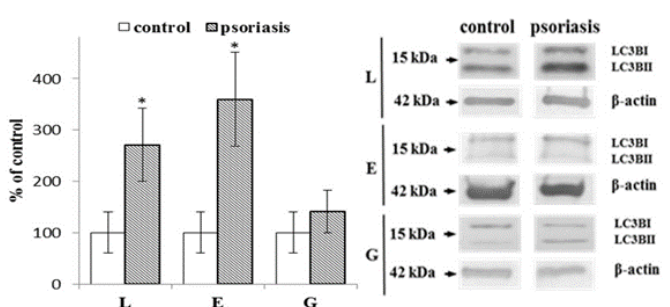
Figure 4. The ratio of LC3BII / LC3BI expression in lymphocytes (L), erythrocytes (E), and granulocytes (G) from psoriatic patients ( n = 6), in comparison to healthy subjects (control), ( n = 6). Values are expressed as a percentage of control. ∗ —statistical significance at p < 0.05 vs. control.